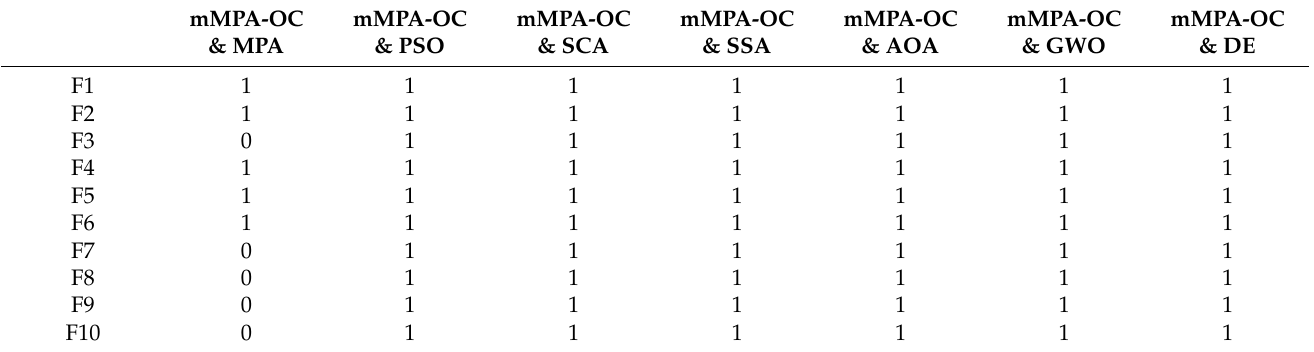
Table 19. Logistic values of Bonferroni–Holm tests for mMPA-OC compared with other algorithms in